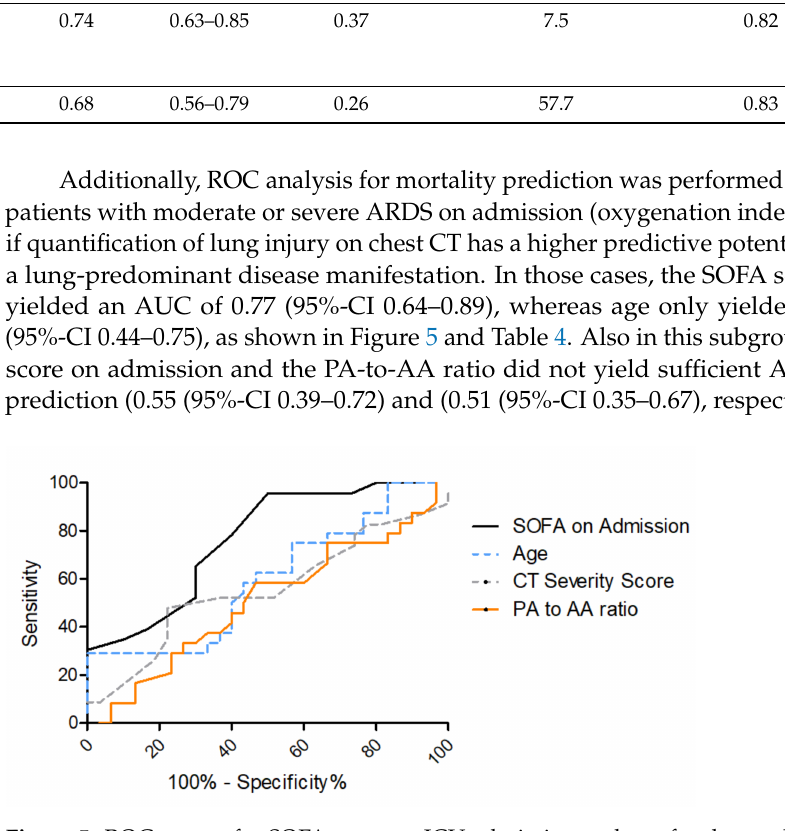
Figure 5. ROC curves for SOFA score on ICU admission and age for the prediction of in-hospital mortality in patients with moderate or severe ARDS on ICU admission. ROC curve for in-hospital mortality according to SOFA score on admission (grey), AUC = 0.77 (95% CI 0.64–0.89) and age (dashed blue), AUC = 0.65 (95% CI 0.42–0.74). Table 4. ROC analysis for the prediction of mortality with Youden index, sensitivity and specificity. AUC, area under the curve; CI, confidence interval; Y-index; Youden index; and SOFA, sequential organ failure assessment